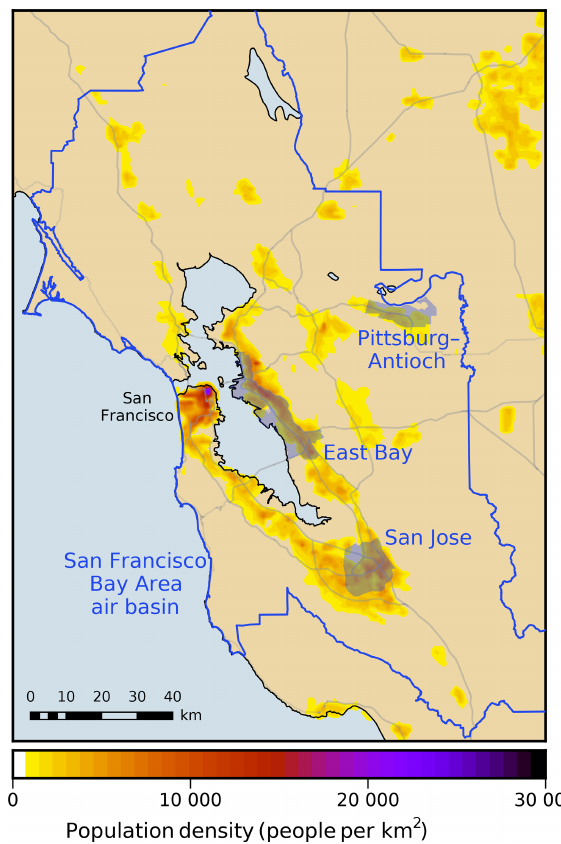
Figure 1. Modeling domain and receptor areas investigated in this work. The color scale shows population density as of the 2010 US Census. Gray lines indicate major